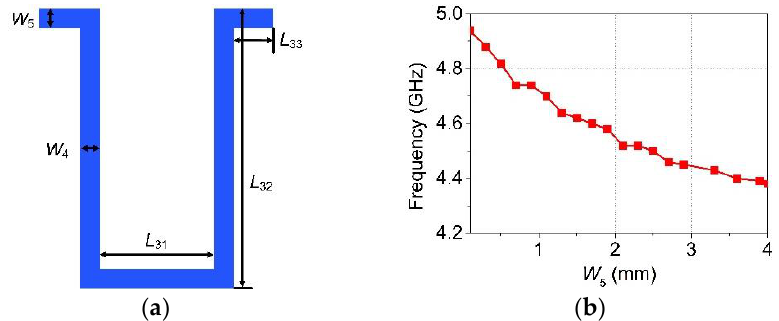
Figure 2. Design of the folded uniform impedance resonator (FUIR). ( a ) Schematic diagram of the FUIR; ( b ) The simulated resonant frequency of the FUIR for various values of W 5 .